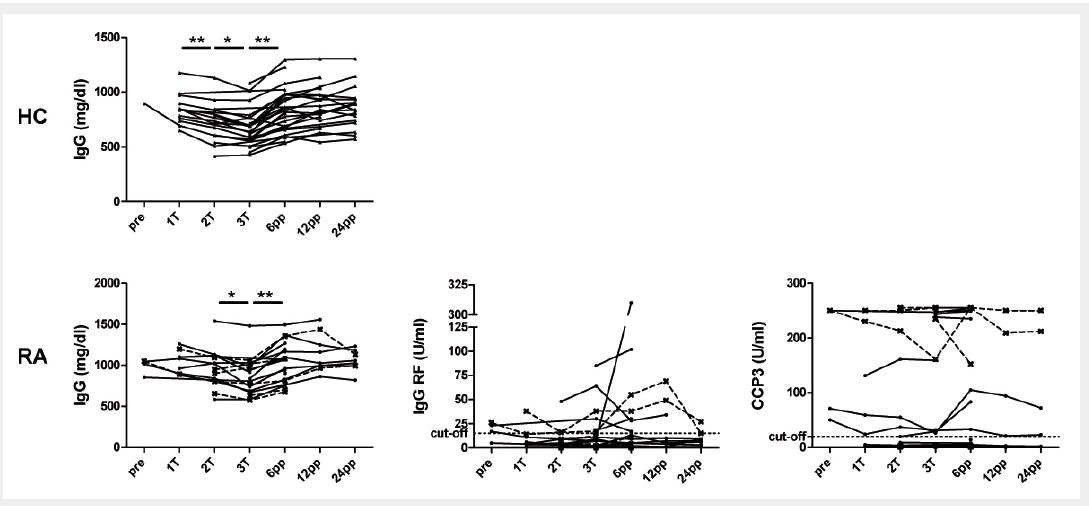
Figure 2 Immunoglobulin levels, IgG-RF and ACPA during and after pregnancy in healthy and rheumatoid arthritis patients. Levels of the immunoglobulin IgG, IgG-RF and IgG-ACPA (anti-CCP3 ELISA) in healthy women (HC, n = 29) as well as in patients with rheumatoid arthritis (RA, n = 22) analysed before conception (pre), at the 1 st (1T), 2 nd (2T) and 3 rd (3T) trimester as well as 6, 12 and 24 weeks post partum (wpp). RF and ACPA levels are shown in RA patients with persistent active disease (dashed lines) and in those with low disease activity during pregnancy (black lines). * P <0.05, ** P